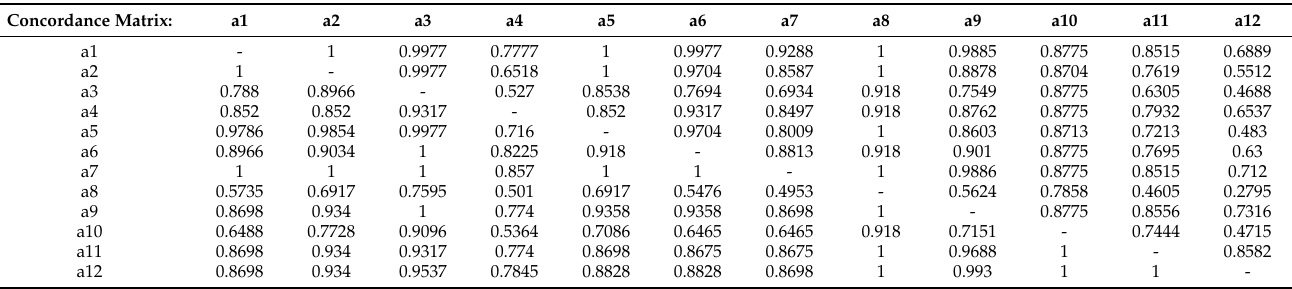
Table 5. Concordance matrix